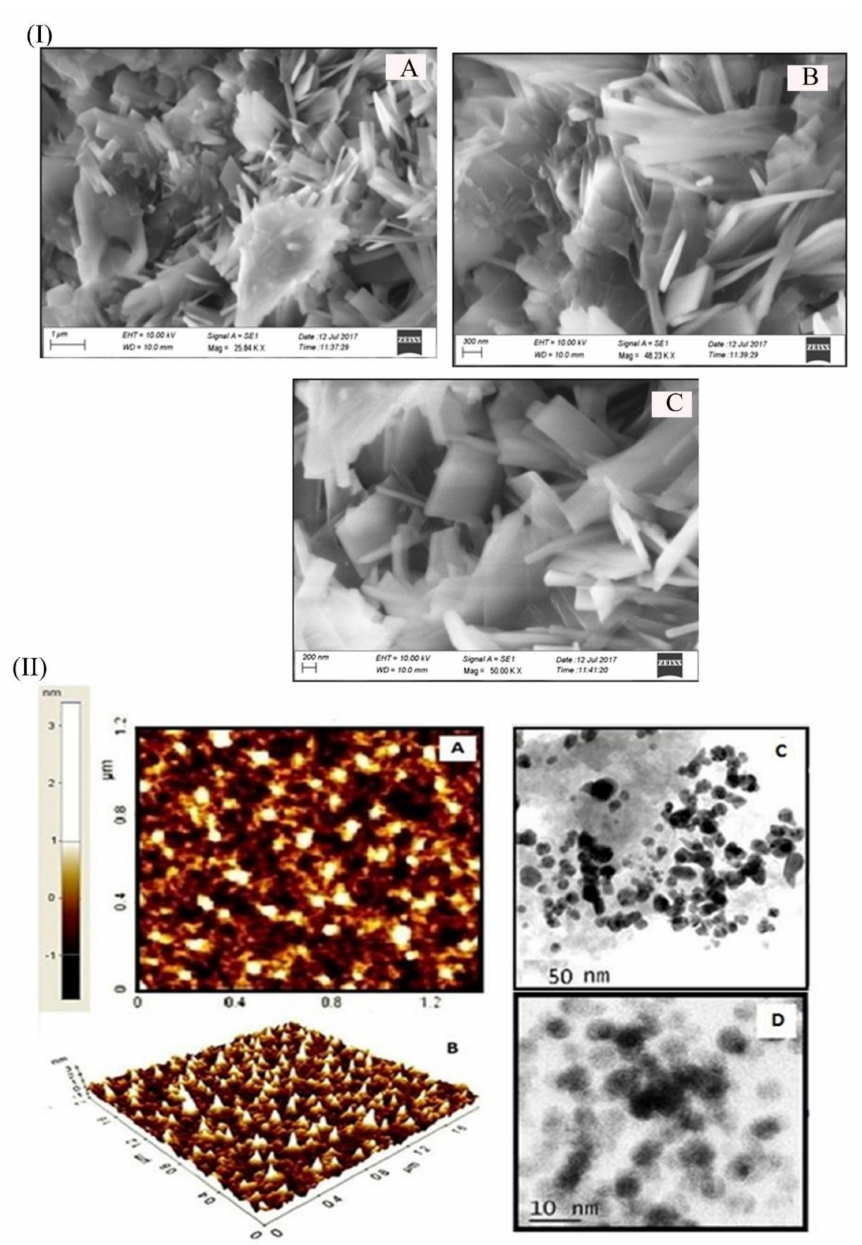
Figure 4. Morphological assessment of L-HAgNPs by ( I ) SEM images at different magnifications: ( A ) 1 µ M, ( B ) 300 nm, and ( C ) 200 nm; ( II ) AFM micrograph: ( A ) 2D image, ( B ) 3D image, and ( C , D ) TEM